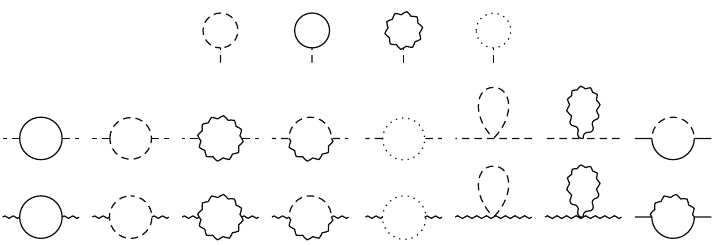
Figure 1: Generic diagrams included by SARAH to calculate one-loop tadpoles and self-energies.